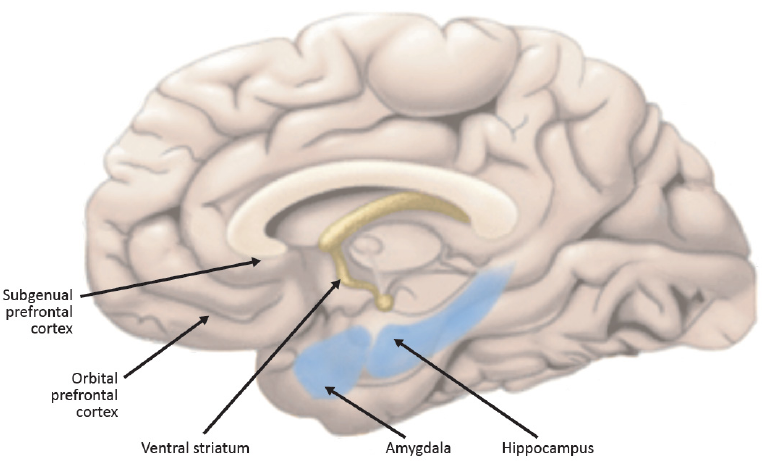
Figure 3. Sagittal section of the human brain. Structures playing a particularly important role in the pathophysiology of depression that are the targets of PPARg-amelioration of multiple core compo- nents of depressive illness. Please see text for descriptions, roles, and